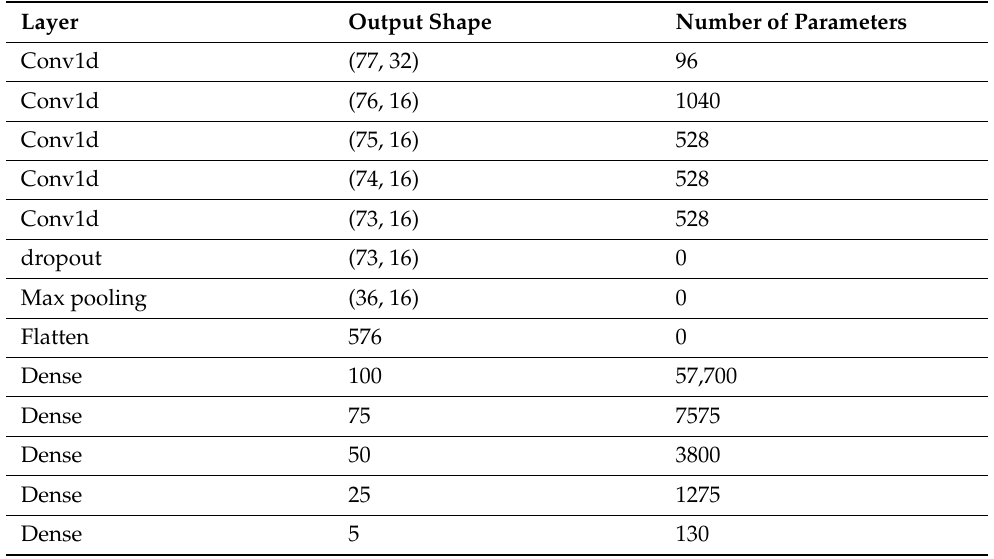
Figure 1. Proposed 1D CNN Architecture. Table 6. Summary of the proposed